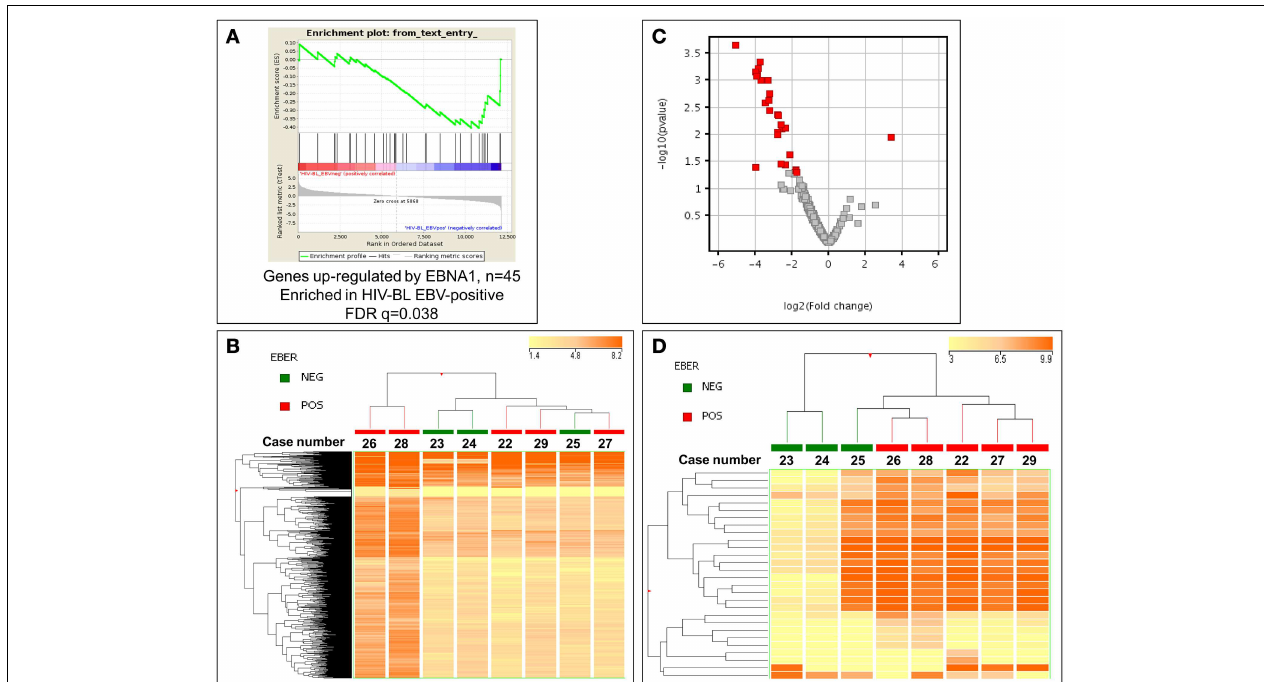
FIGURE 3 | EBV might interfere with gene and microRNA expression profiling of EBV-positive and EBV-negative ID-BL. (A) GSEA shows differential expression of the genes up-regulated by EBNA-1 between ID-BL EBV-positive and ID-BL EBV-negative ( n = 45 ). GSEA was done with a list of genes up-regulated by EBNA-1 obtained by Dresang et al. (2009). After filtering and normalization, the ∼ 12,000 genes included in the microarray are ranked on the X axis (“rank in ordered data set”) of the graph from left to right. Genes on the left are up-regulated in EBV-negative cases, whereas the genes ranked to the right are up-regulated in EBV-positive cases. Green line represents the enrichment score (ES, Y axis ) with a maximum (absolute value) ES at ∼ -0.4; black vertical lines, position of individual genes (up-regulated by EBNA-1) from the used gene set in the ordered list of ∼ 12,000 genes. To derive significance, the data set was permuted 1000 times and random ES were calculated. The FDR-q- value was = 0.038, indicating that the observed